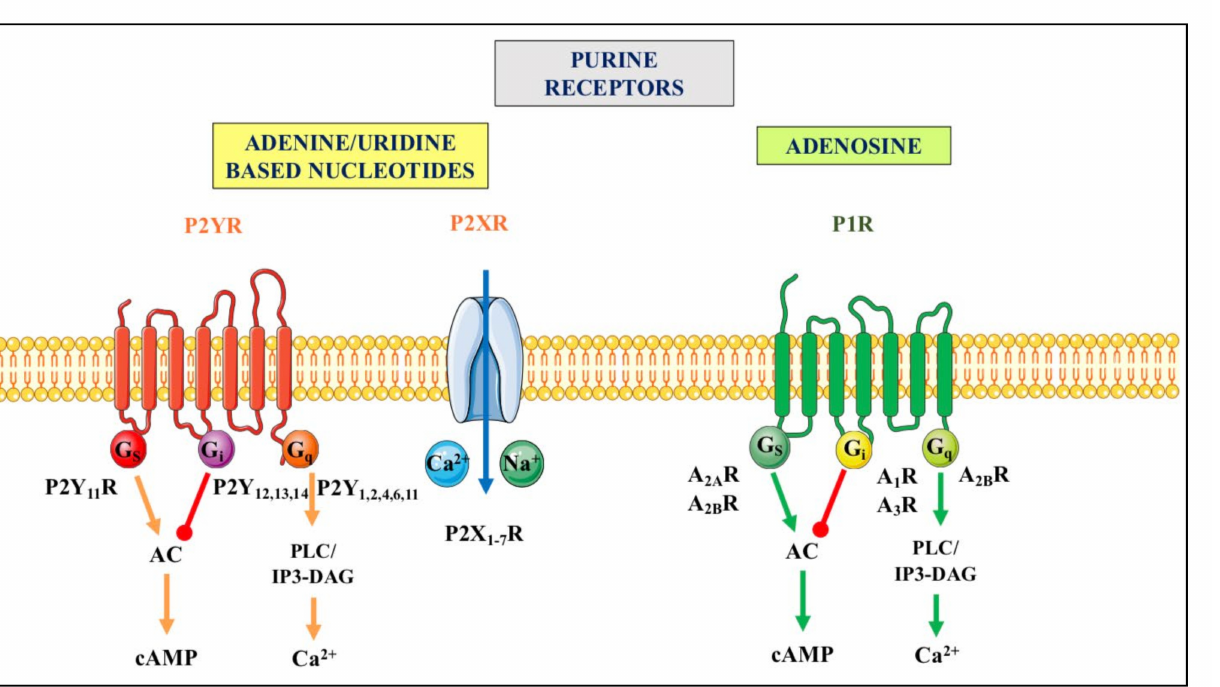
Figure 2. Purinergic receptors. They are divided in two principal families named P1 and P2. The P1 re- ceptor (P1R) family includes four subtypes (A 1 R, A 2A R, A 2B R and A 3 R), which are all metabotropic G proteins-coupled receptors [34]. The P2 receptor (P2R) family is subdivided into seven ionotropic P2X (P2XR), which are activated by ATP, and eight metabotropic P2Y receptors (P2YR), of which P2Y 1 R respond to ATP and ADP, P2Y 2,4,6 R are mainly activated by uridine-based nucleotides, P2Y 12,13 R re- spond to ADP, and P2Y 14 R to UDP-glucose (as recently reviewed by [35,36]). Ionotropic P2XR, when stimulated, allow the entry of cations such as Na + and or Ca 2+ into cells while metabotropic receptors belonging to the P1R family or to the P2YR subtypes are coupled to different G proteins and down- stream molecular pathways indicated above. For major details see [37]. Abbreviations: AC, adenylate cyclase; cAMP, cyclic AMP, PLC/IP3-DAG, phospholipase C/inositol